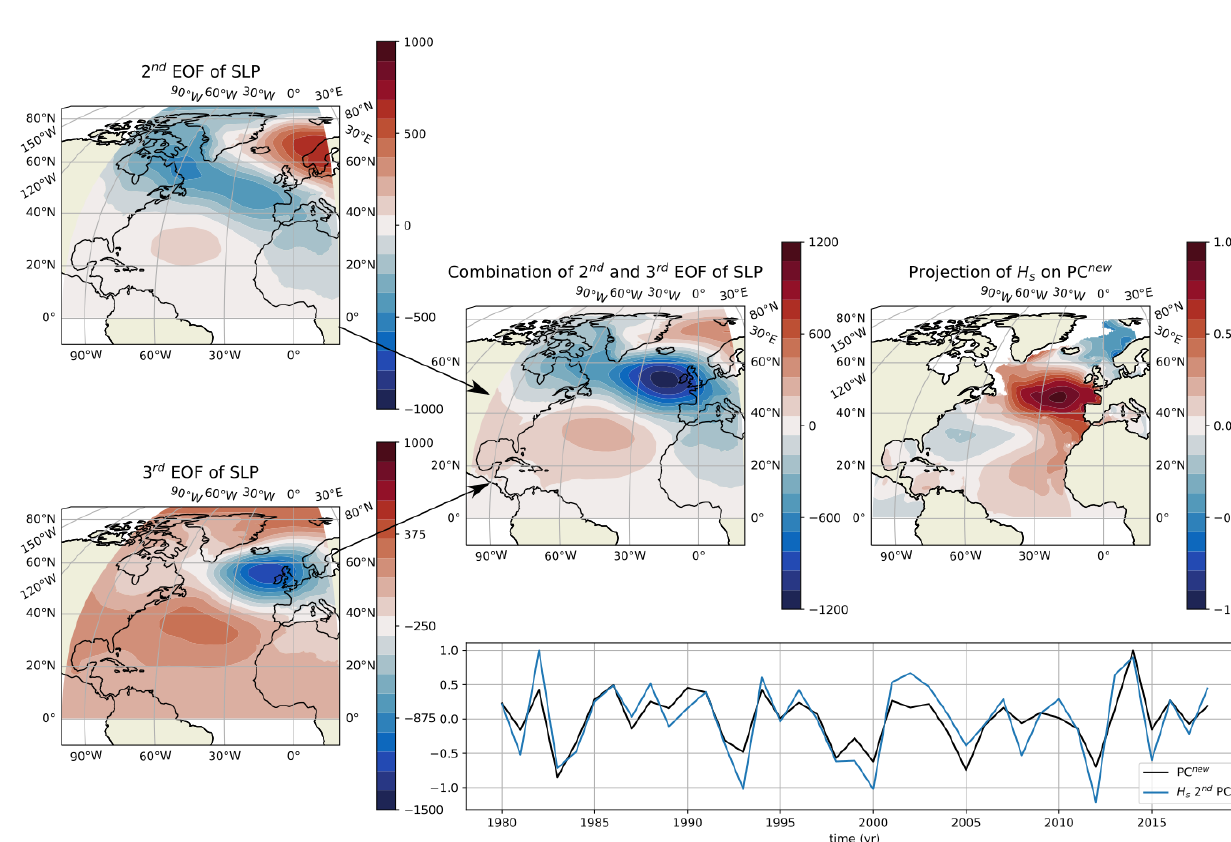
Figure A1. Combination of the second (top-left panel) and third EOF (bottom-left panel) of SLP to give the new pattern on the middle panel associated with PC new (see Equation (A1)) shown by a black line on the bottom right panel. PC new has a good correlation (0.87) with the second H s EOF PC (blue line, bottom right panel) and explains respectively 21% and 12% of the H s and SLP variance. The projection of H s on PC new is shown on the right